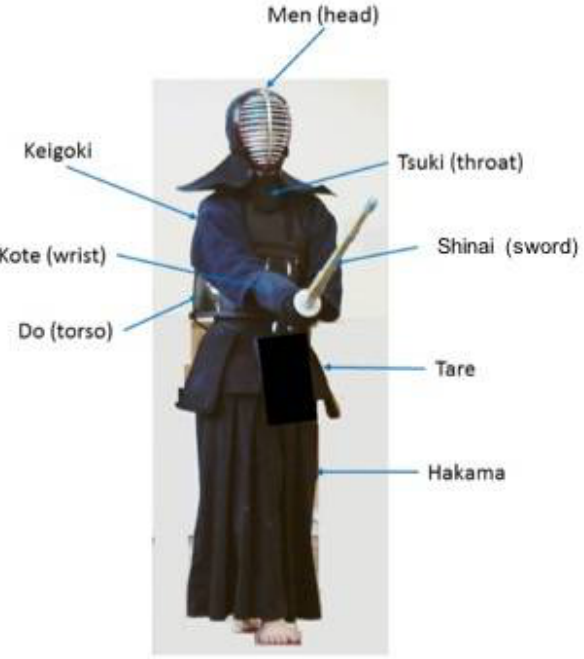
Figure 1. Illustration of kendo uniform (Keigoki and Hakama), armours (Men, Kote, Do and Tare) and sword (Shinai); Photo courtesy© University of Melbourne Kendo club, reproduced with kind